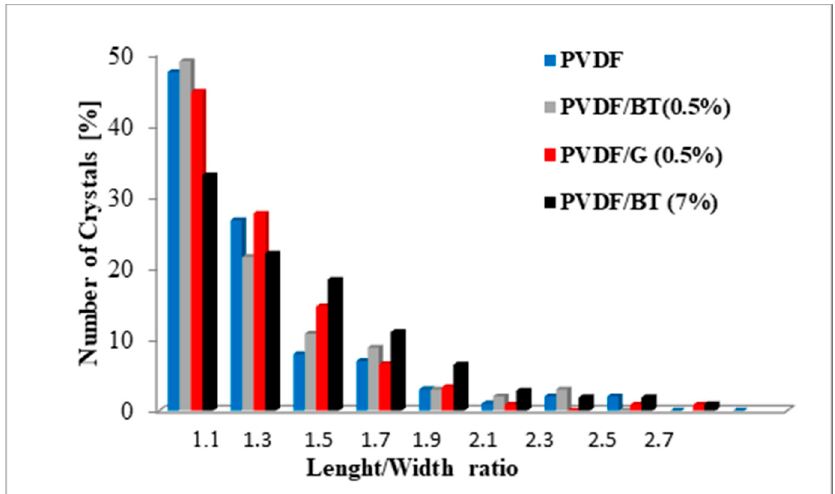
Figure 9. Percentage of crystals in function of length/width ratio for the pristine and functionalized PVDF-based membranes.